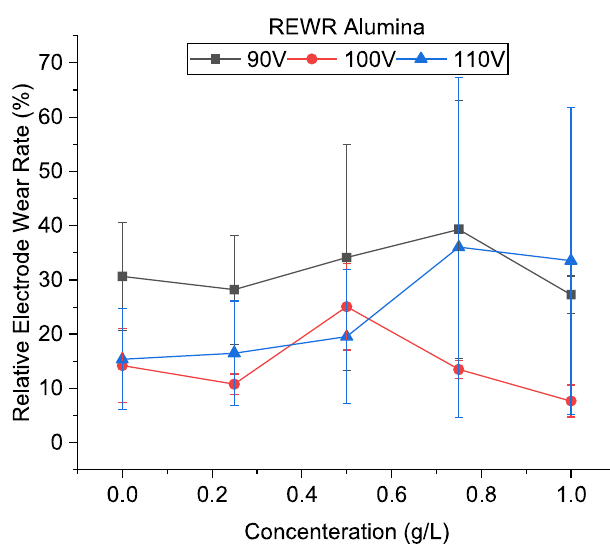
Figure 16. Relative electrode wear using alumina-mixed